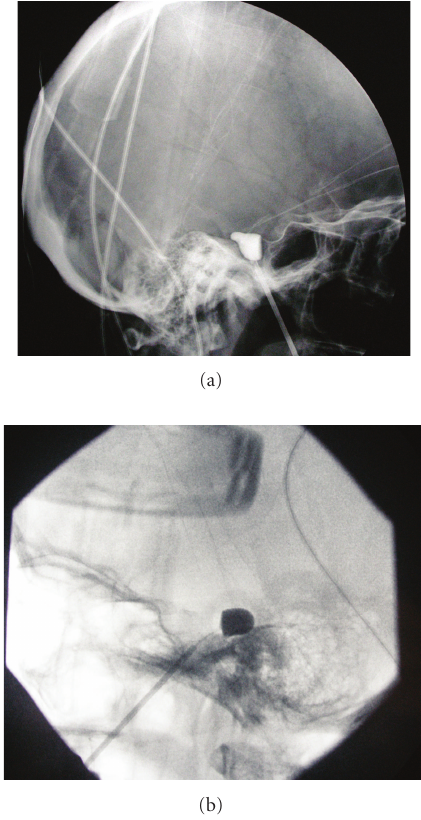
Figure 2: The balloon catheter was introduced through the needle and navigated into Meckel’s cave. The shape showed if the balloon was in the appropriate position: (a) ideal pear shape; (b) not ideal shape.